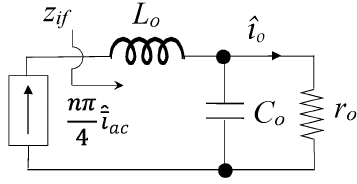
Figure 10. Small-signal response of the output current.